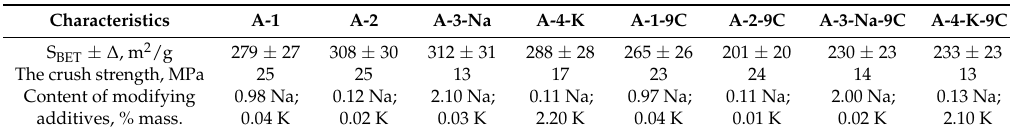
Table 2. Texture characteristics, the crush strength values, and modifications to the content of additives in the alumina samples before and after pressure tests.